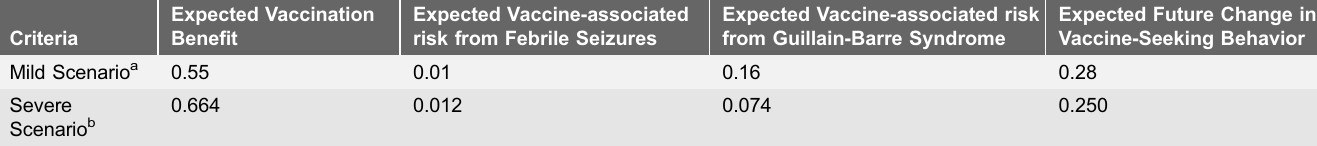
Table 1. Averaged Scaling Constants of the Expert Panel for Multi-Criteria Decision Analysis.